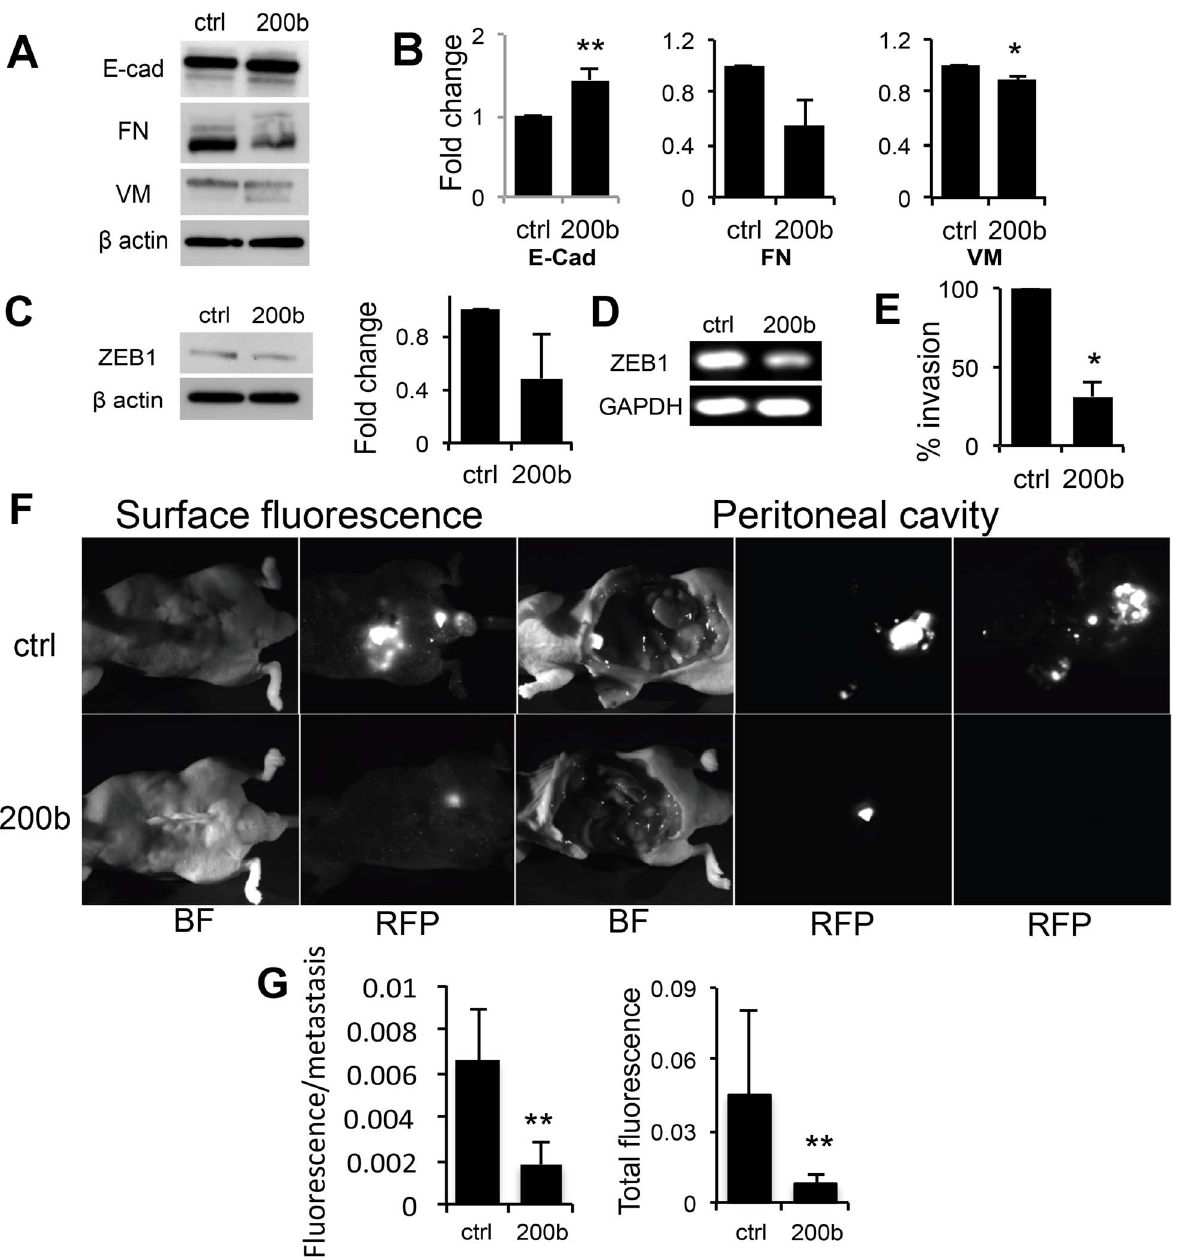
Figure 5. miR-200b reverses EMT and decreases invasion and metastasis by PC3 cells. (A) Markers affected by miR-200b in PC-3 cells. E-cadherin, Fibronectin, and Vimentin were detected in whole cell lysates from PC3 ctrl and PC3 miR-200b cells by western blot. (B) Quantitative analysis of the experiment shown in (A) performed with Image J software. *, p , 0.05 and, **, p # 0.01 as determined by Student’s T-test. Two independent experiments were pooled together. (C) Western blot for ZEB1 and quantification performed as above (the average of two experiments is shown). (D) End-point PCR for ZEB1. (E) In vitro transwell invasion assay: the comparison of PC3-ctrl and PC3 miR-200b cells. 10% FBS was used as chemoattractant and the experiment was performed in duplicate. *, p , 0.05 by Student’s T-test. (F) The in vivo spontaneous metastases by PC3-ctrl and PC3 miR-200b cells. The cells were implanted orthotopically in the ventral prostates of male nude mice. The mice were subjected to whole body imaging for RFP-positive masses using Surface image. At the end of experiment, the animals were sacrificed, peritoneal cavity opened and metastasis visualized by fluorescence imaging after the removal of a primary tumor inside the peritoneal cavity and on the frontal wall of the abdomen (Peritoneal cavity). Bright field (BF) and fluorescence (RFP, red fluorescent protein) are shown. (G) Quantification of the experiment shown in (F). The metastases were counted and total fluorescence per metastasis calculated (left). Gross metastatic burden was estimated as total fluorescence per mouse. Ctrl indicates control and 200b indicates miR-200b. **, p # 0.01 by Student’s